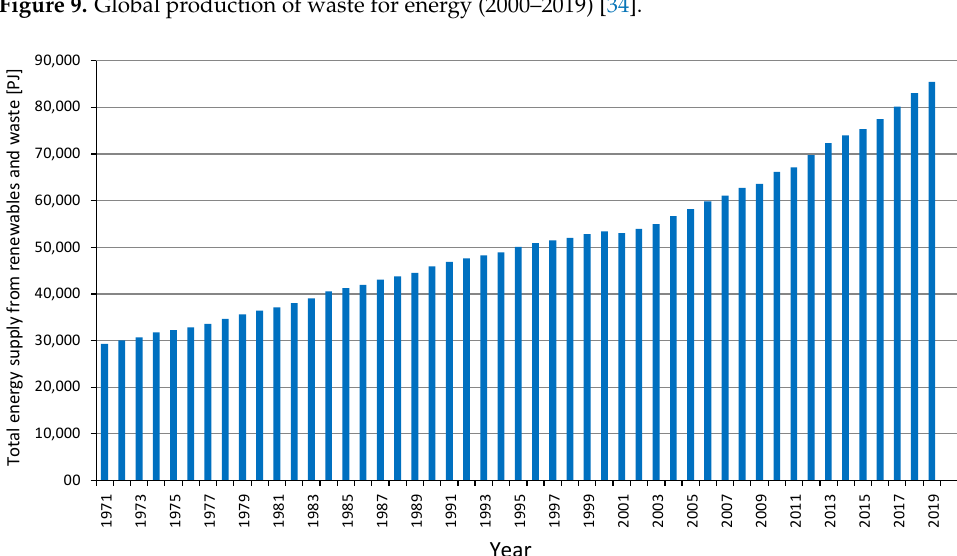
Figure 10. Global total energy supply from renewables and waste [35].